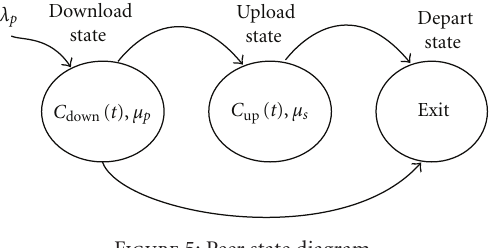
Figure 5: Peer state